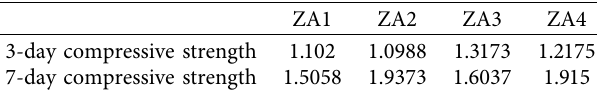
Table 18: Strength level results of the parallel tests. Table 19: Resistivity test results ( Ω ·